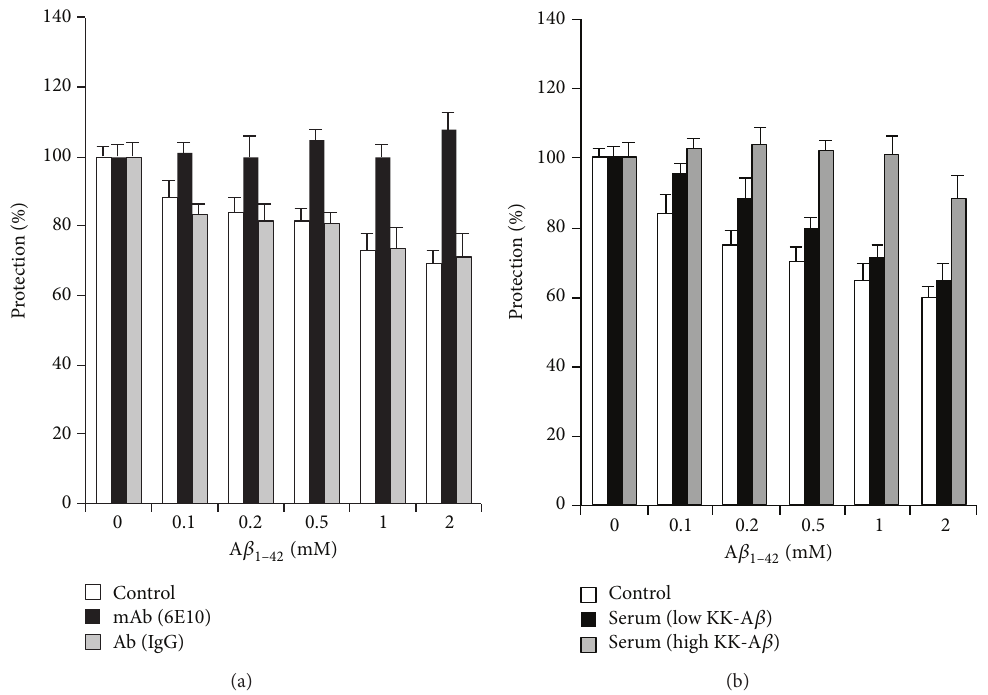
Figure 3: Effects of antiserum from cynomolgus monkeys vaccinated with RGD-DiTox 20 -KK-A 𝛽 1 cytotoxicity of PC12 cells. The effects of the anti-A 𝛽 monoclonal antibodies (positive control: black bar) and nonspecific immunoglobulin (gray bar) on the cytotoxicity of A 𝛽 peptides (base control of cytotoxicity: white bar) are indicated (a). The effects of the serum of A 𝛽 1 peptide-immunized monkey (0.5 mg/head low dose: black bar, and 2.5 mg/head high dose: gray bar) on the cytotoxic A 𝛽 42 peptides (buffer control: white bar) are